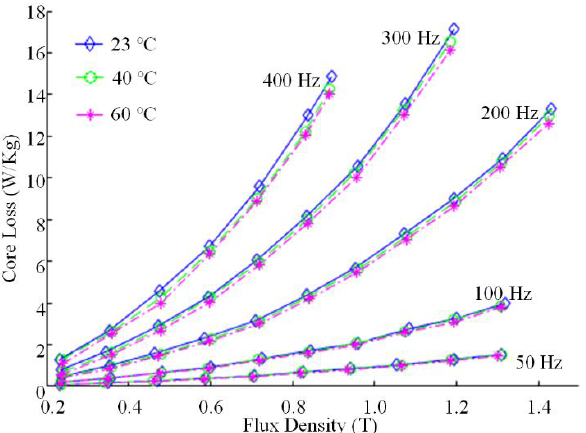
Figure 2. Measured core loss in the Epstein frame at different frequencies, flux densities, and temperatures.